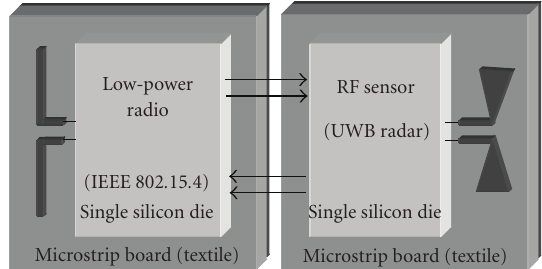
Figure 1: Wearable wireless interface for the heart monitoring: sys- tem idea.